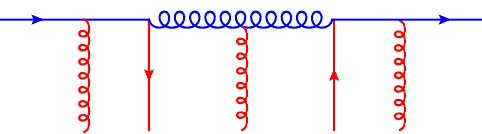
Figure 2 . Typical diagram for quark propagator in the background of quark (cid:12)elds. We indicate in blue the quantum (cid:12)eld while in red the background